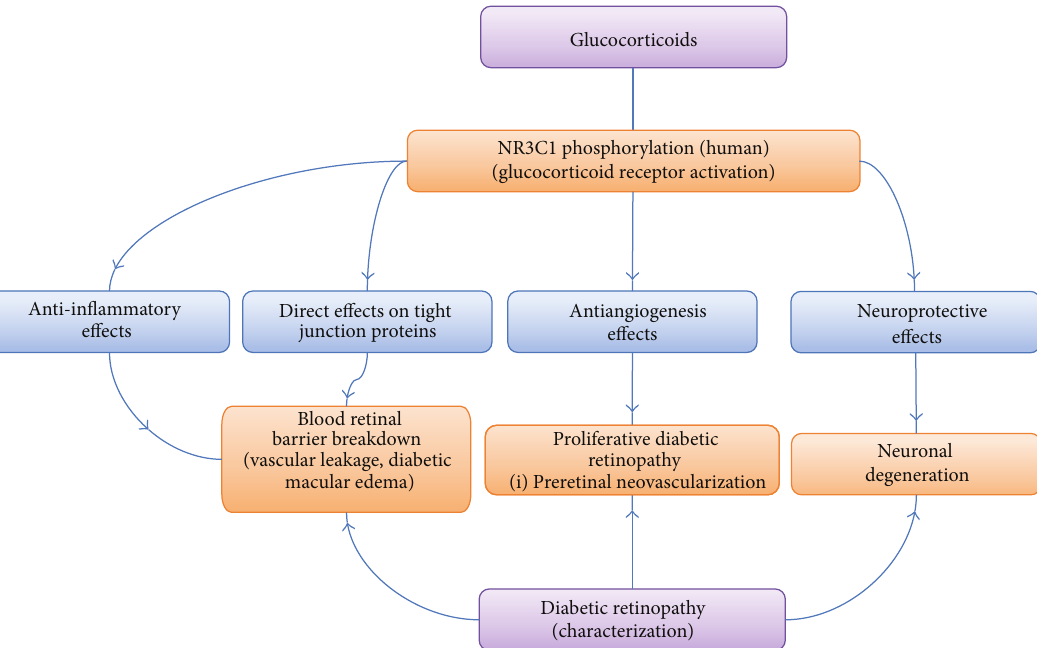
Figure 3: Effects of glucocorticoids on diabetic retinopathy. Glucocorticoids act through several pathways to counteract the negative aspects of DR on the eye. Source: